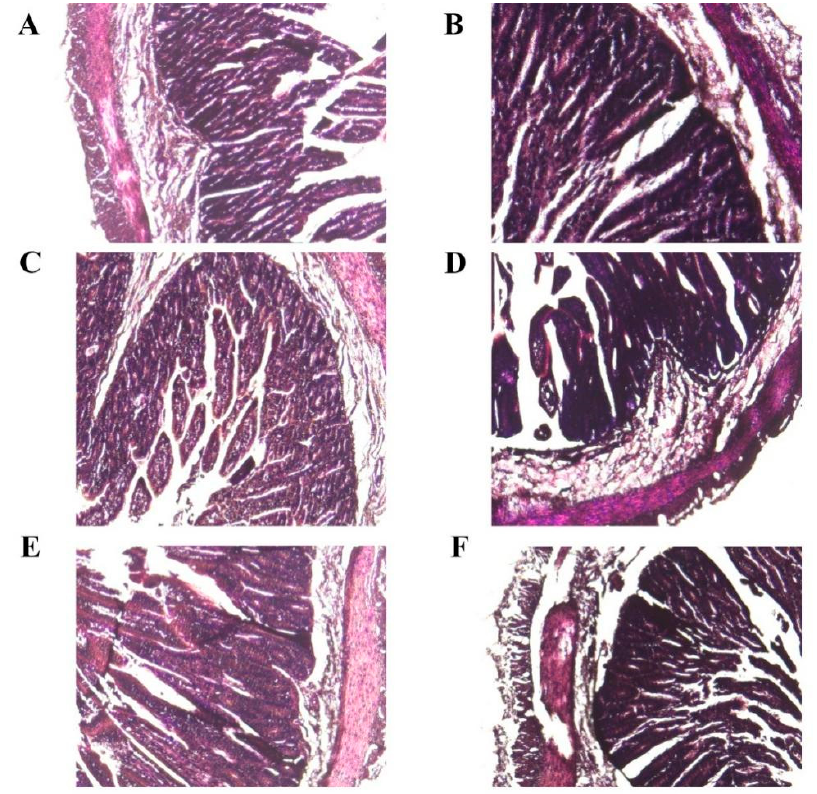
Figure 3. Pathological tissue section of healthy ( A , C , E ) lambs and diarrheic ( B , D , F ) lambs. (40×). ( A ,B) Duodenum; ( C , D ) jejunum; ( E , F ) ileum.